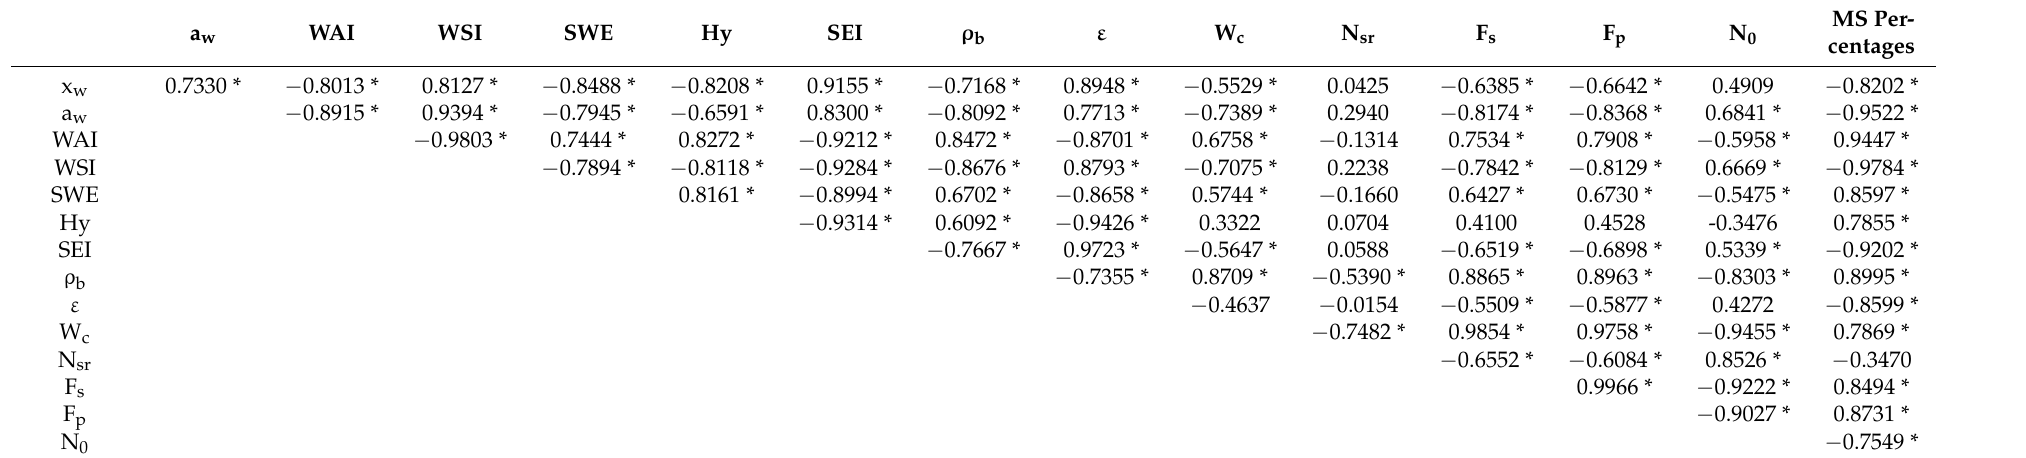
Table 2. Pearson correlation coefficients among studied parameters of extruded